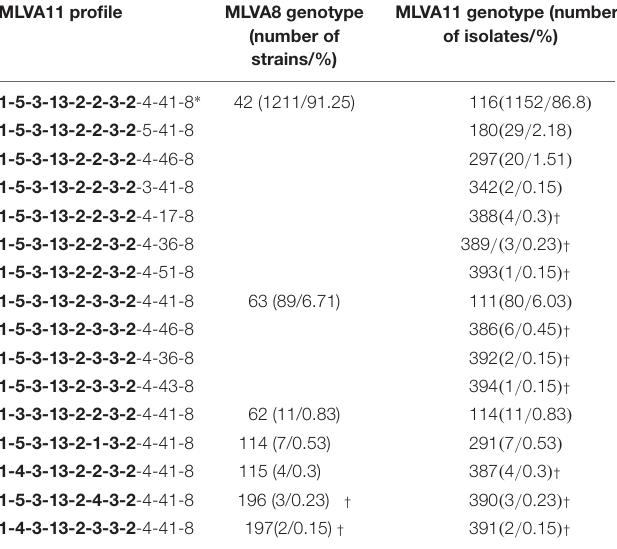
TABLE 3 | Distribution of genotypes by MLVA8 and MLVA11 in Kazakhstan. MLVA11 profile MLVA8 genotype